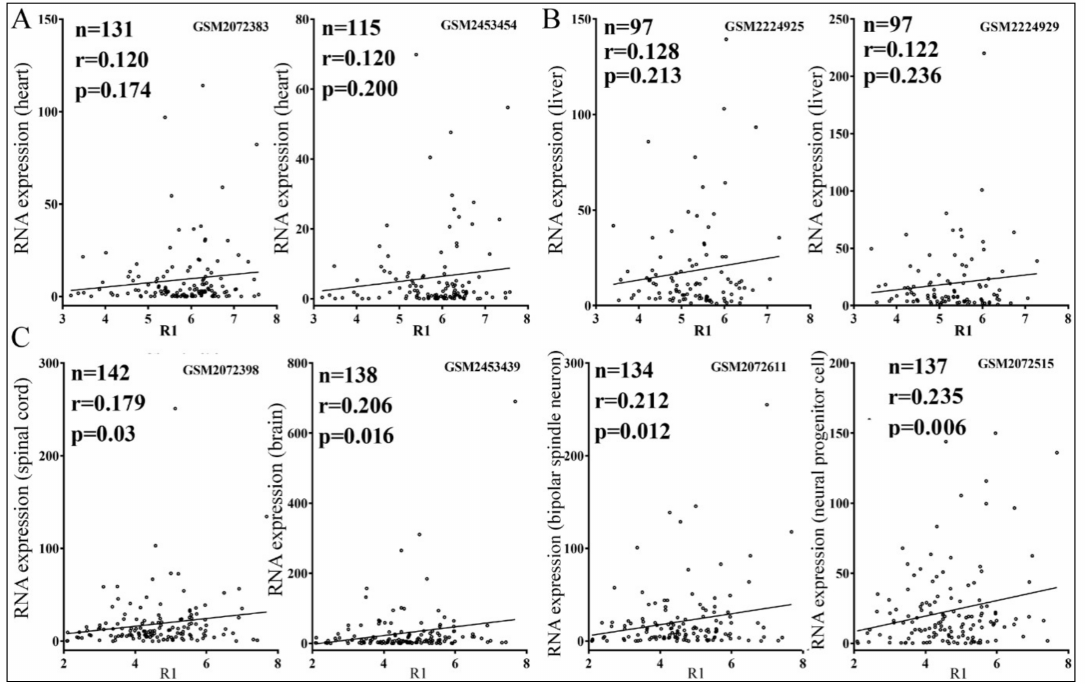
Figure 7. Pearson correlations between human endogenous gene expression and target reporter inhibition. ( A ) Correlations between RNA expression in the heart ( y -axes) and miR-1 target R1 values ( x -axes). ( B ) Correlations between RNA expression in the liver ( y -axes) and miR-122 target R1 values ( x -axes). ( C ) Correlations between RNA expression in the nervous system and neurons ( y -axes) and miR-124 target R1 values ( x -axes). Little circles represent individual confirmed targets. The sample size ( n ), correlation coe ffi cients (r), p -values, and the corresponding Gene Expression Omnibus dataset accession numbers are